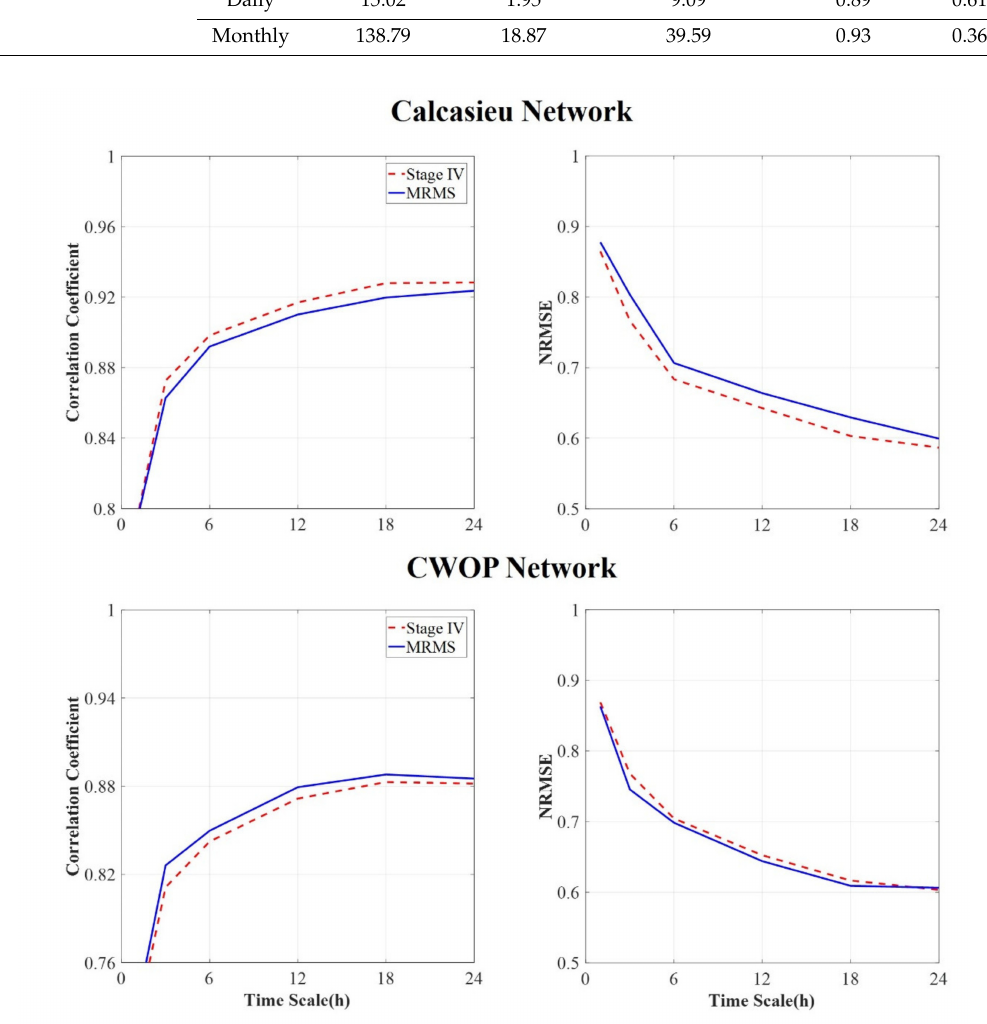
Figure 7. Correlation coe ffi cient and normalized root mean square error (NRMSE) of radar and gage estimates as a function of di ff erent temporal